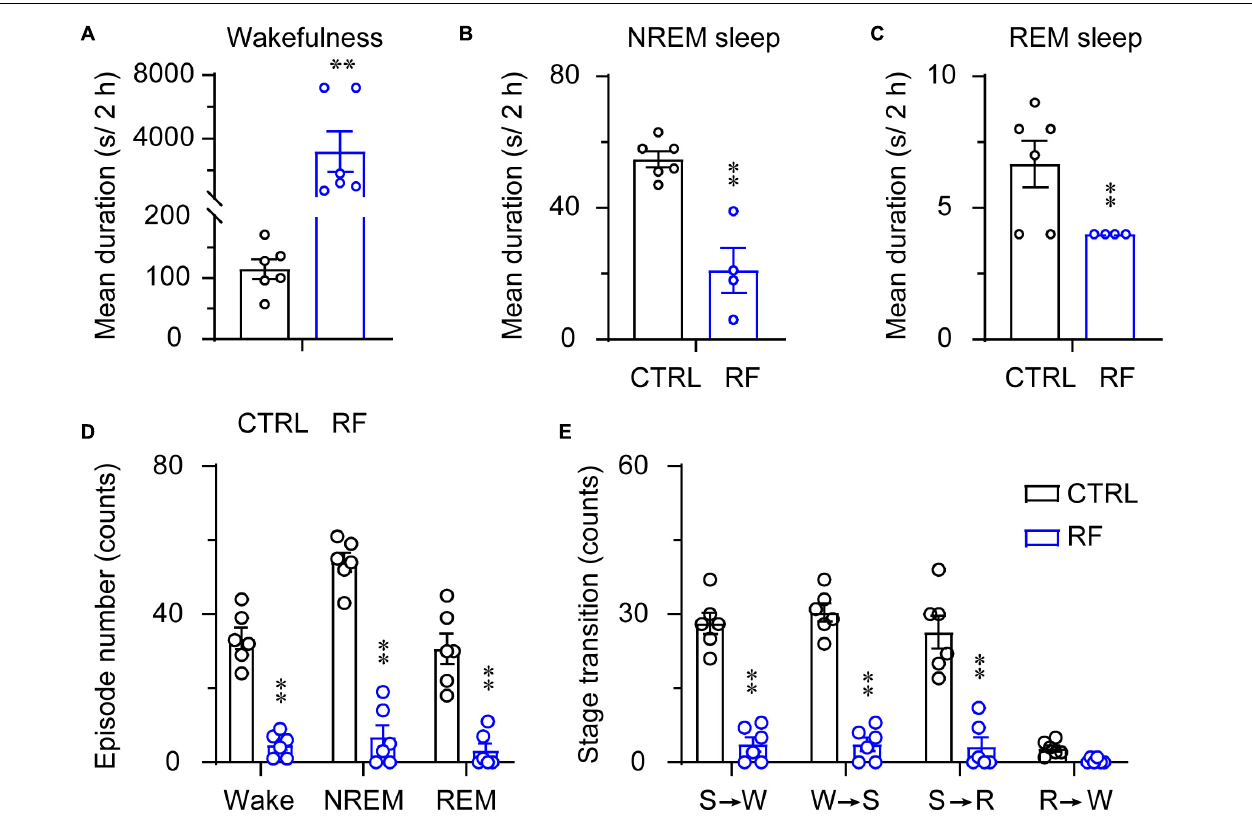
FIGURE 6 | Sleep-wake architecture in the RF and CTRL groups on day 14 of the RF protocol. The mean durations of wakefulness (A) , NREM sleep (B) , REM sleep (C) , and number/type of episode during each stage (D) during the 2 h proceeding the dark period (food availability). (E) Transitions between stages during the 2 h proceeding the dark period. ∗∗ p < 0.01 versus CTRL, n = 6. CTRL, control; RF, restricted feeding; R, REM sleep; S, slow-wave sleep; W,